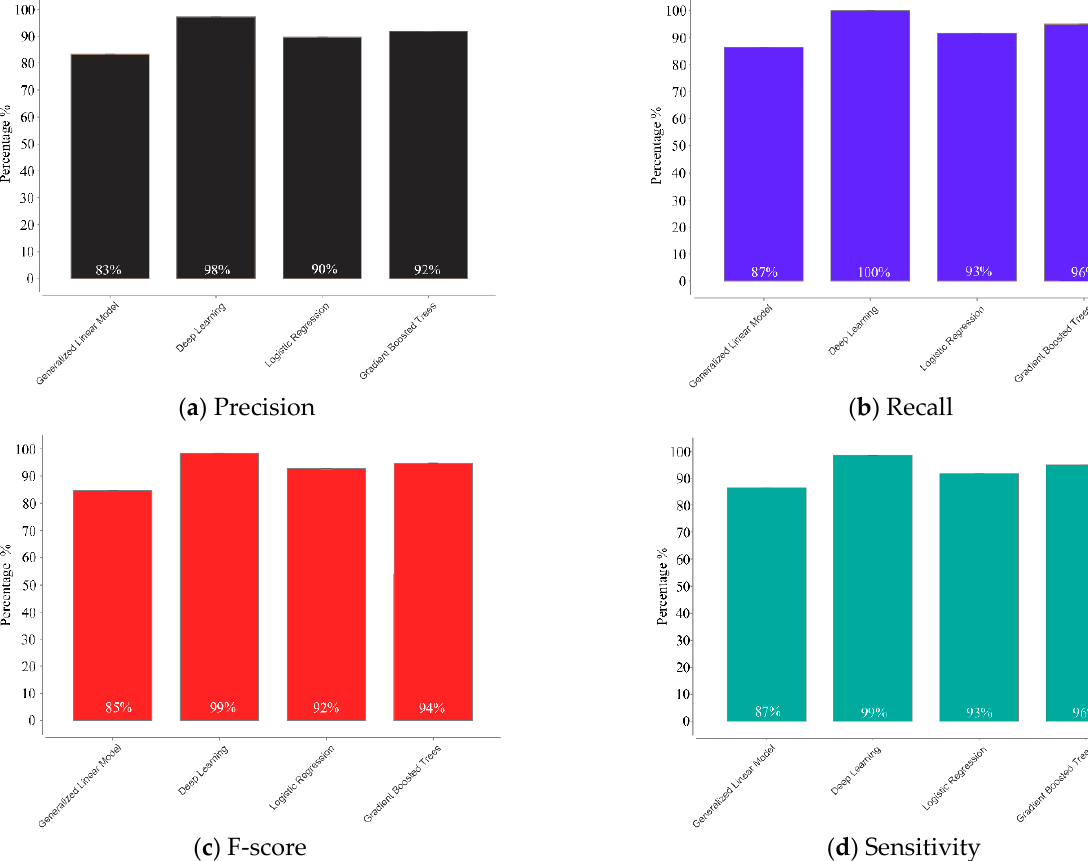
Figure 6. ( a – d ) Performance matrices for proposed machine-learning models.